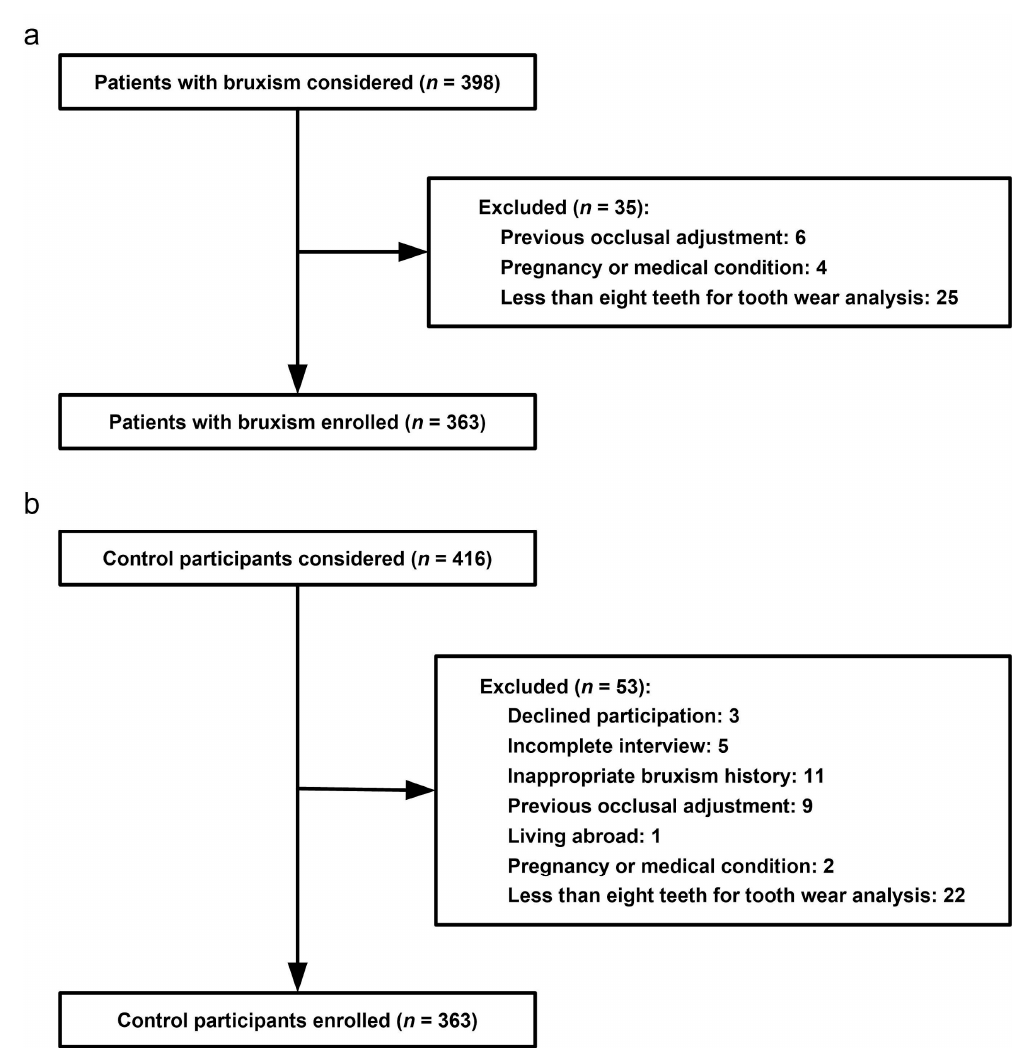
Figure 1. ( a ) Flow diagram of case subject enrollment; ( b ) flow diagram of control subject